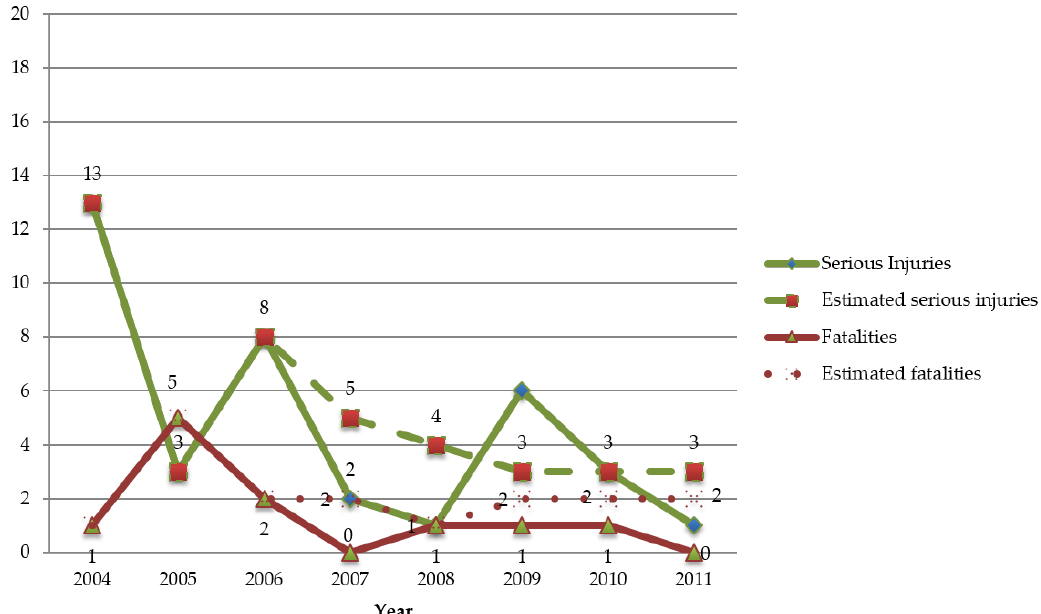
Figure 4. Comparison of crashes and light injuries with the estimated values of the control group (I).